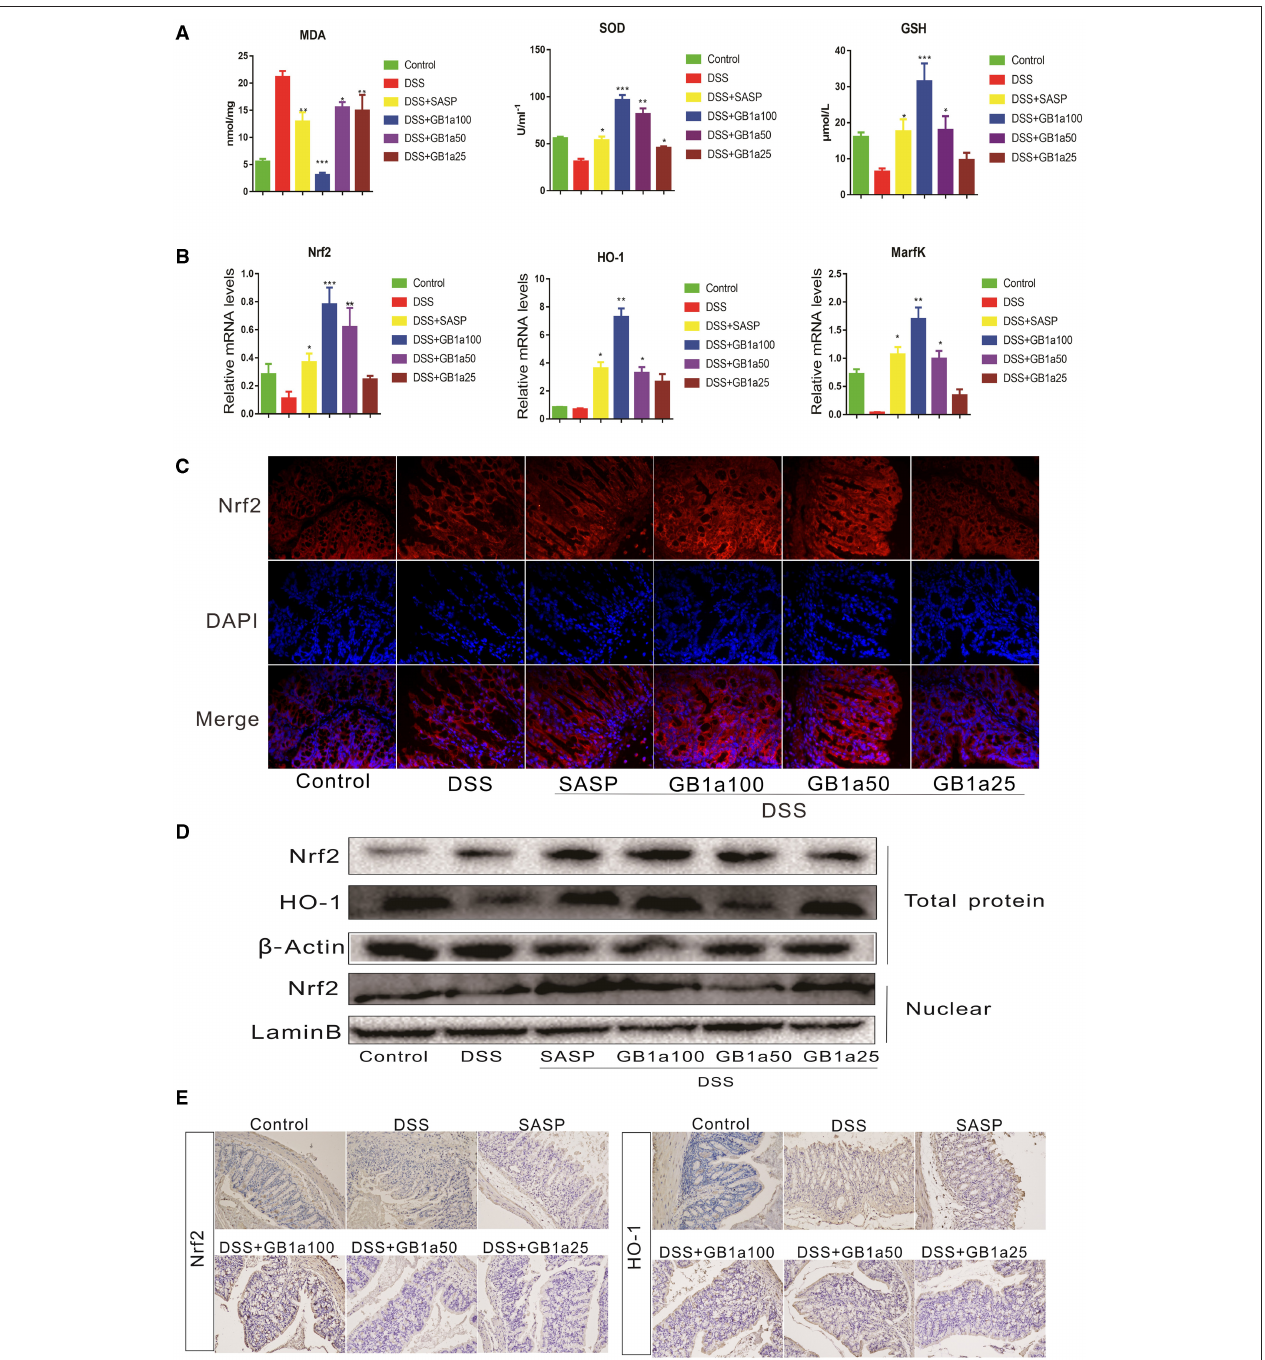
FIGURE 5 | The effects of GB1a on the activation of the Nrf2 signaling pathway in UC mice. (A) GB1a administration reduced the levels of oxidants (MDA) and increased the levels of antioxidants (GSH, SOD) in the serum of UC mice. (B) GB1a treatment upregulated the expression of antioxidant genes Nrf2, HO-1, and MarfK. (C) Immunofluorescence analysis of Nrf2 (red) in the colon of mice. DAPI was used for nuclear staining (blue). (D) GB1a administration increased the expression of Nrf2 and HO-1 proteins and promoted Nrf2 translocation to the nucleus. (E) Representative images of immunohistochemical staining of Nrf2 and HO-1 in mice colon sections. Data are presented as means ± SD ( n = 7/group). * p < 0.05, ** p < 0.01, and *** p < 0.001 vs. the DSS-incubated